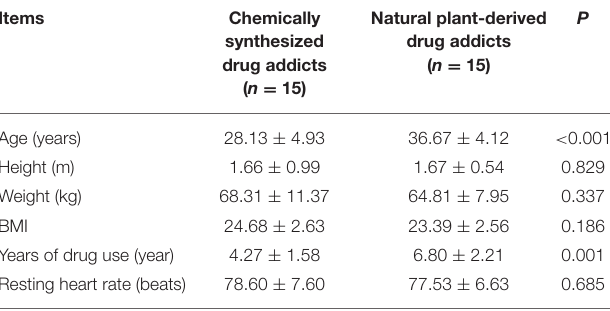
TABLE 1 | The demographic characteristics of subjects.